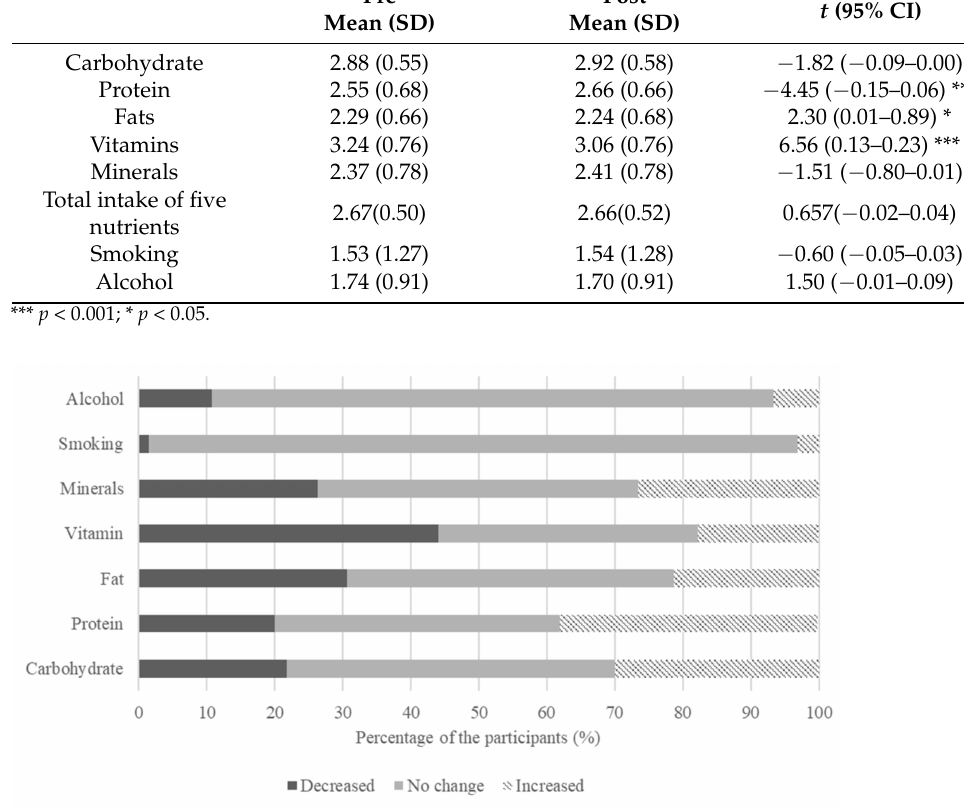
Figure 3. Percentage of population that reported differences in nutritional intake frequency pre and post the outbreak of